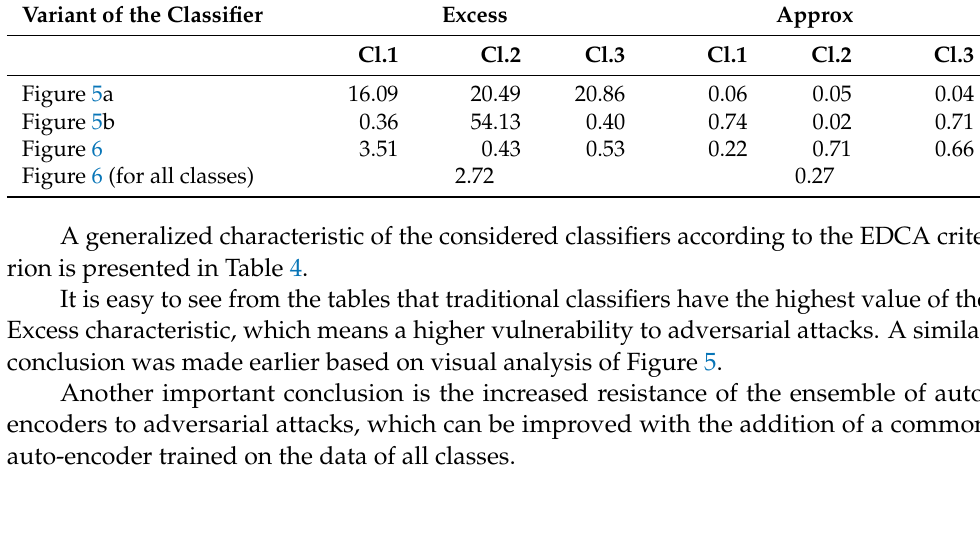
Table 3. Excess and Approx values for individual classes. Variant of the Classifier